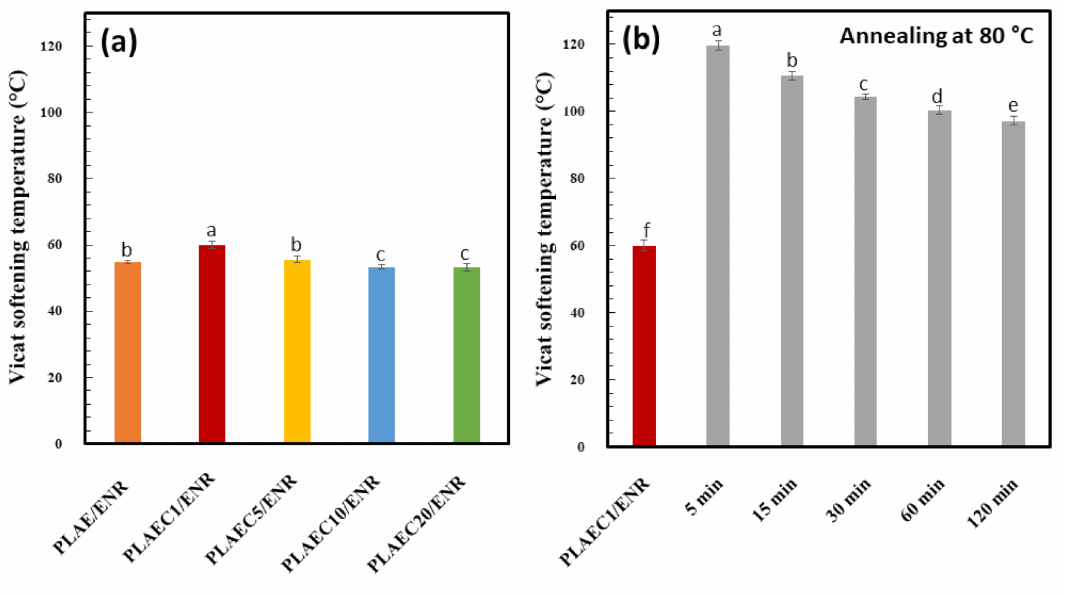
Figure 8. Vicat softening temperature of ( a ) PLAE/ENR blend with 0.5–20% CTS and ( b ) PLAEC1/ ENR blend with different annealing times (0–120 min) at 80 ◦ C. Means with different lowercase letters were significantly different ( p <